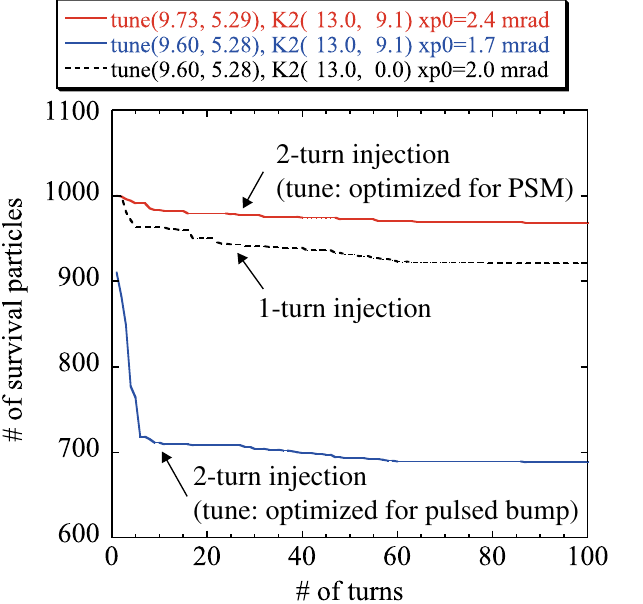
FIG. 10. (Color) Capture efficiency as a function of the injection angle. The circles, squares, and diamonds show the efficiencies when the injection timings are 0, 450, and 600 ns, respectively. The operating tune is ð (cid:7) x ; (cid:7) y Þ ¼ ð 9 : 60 ; 5 : 28 Þ .